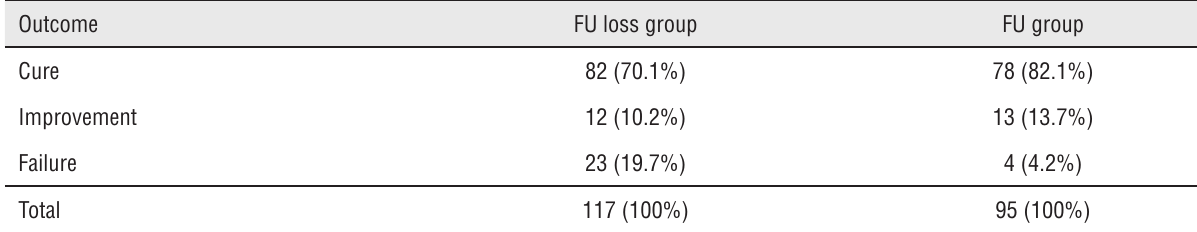
Table 3 - Outcome of the surgical procedure in two